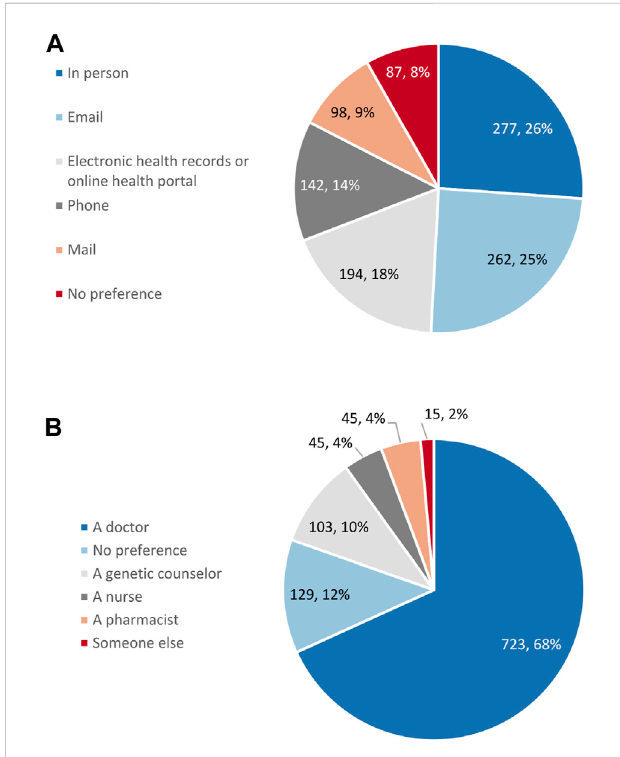
FIGURE 5 Respondent preference for (A) the method for the return of pharmacogenetic results ( n = 1,060) and (B) who would explain pharmacogenetic results ( n =